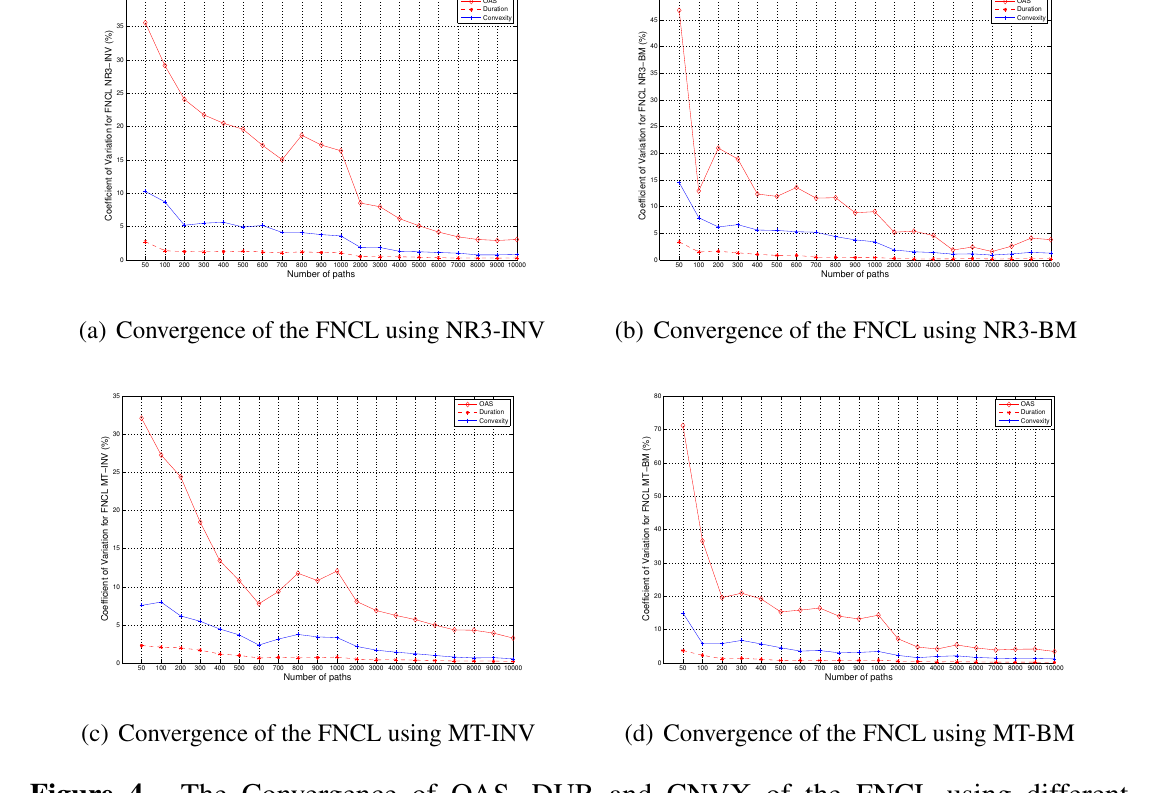
Figure 4. The Convergence of OAS, DUR and CNVX of the FNCL using different random number generator combinations, NR3-INV, NR3-Box–Müller (BM), Mersenne twister (MT)-INV and MT-BM. The vertical axis is for the coefficient of variation (%). The horizontal axis is the number of